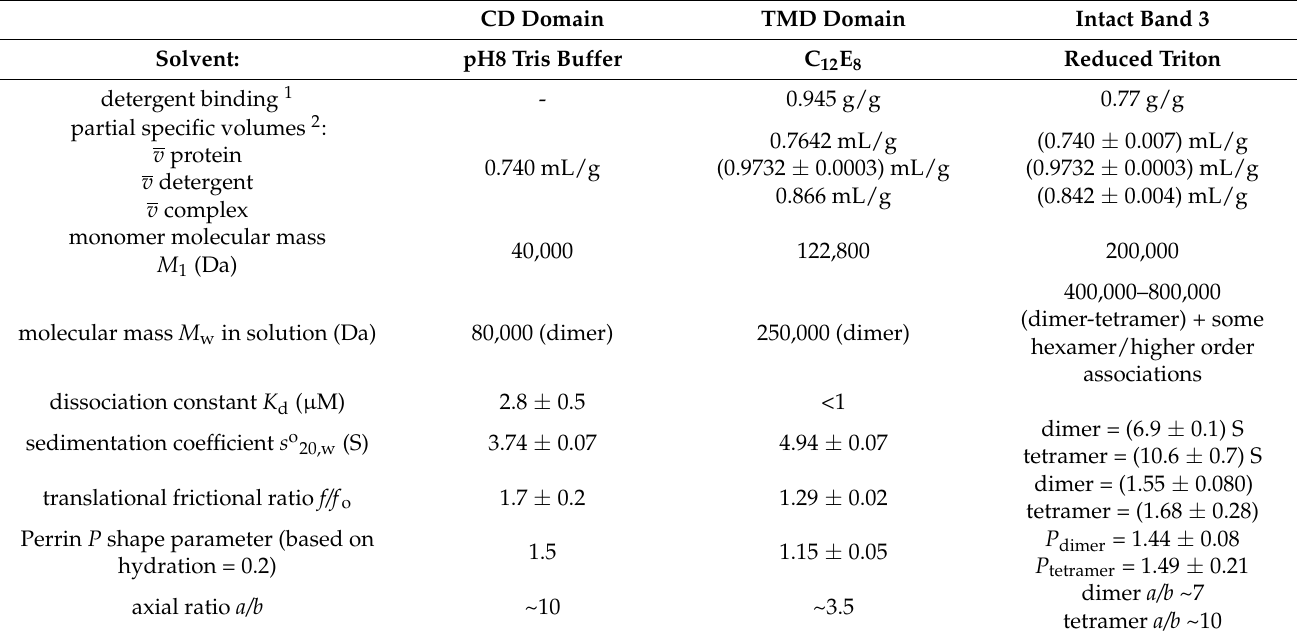
Table 1. Comparative hydrodynamic parameters for the intact band 3 protein, and its cytoplasmic (CD) and transmembane (TMD) domains examined